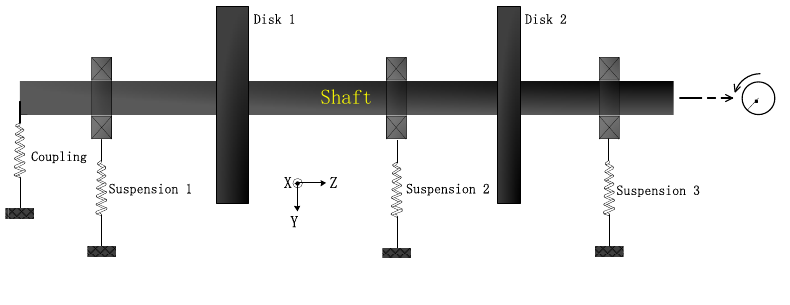
Figure 5. The model of rotor bearing